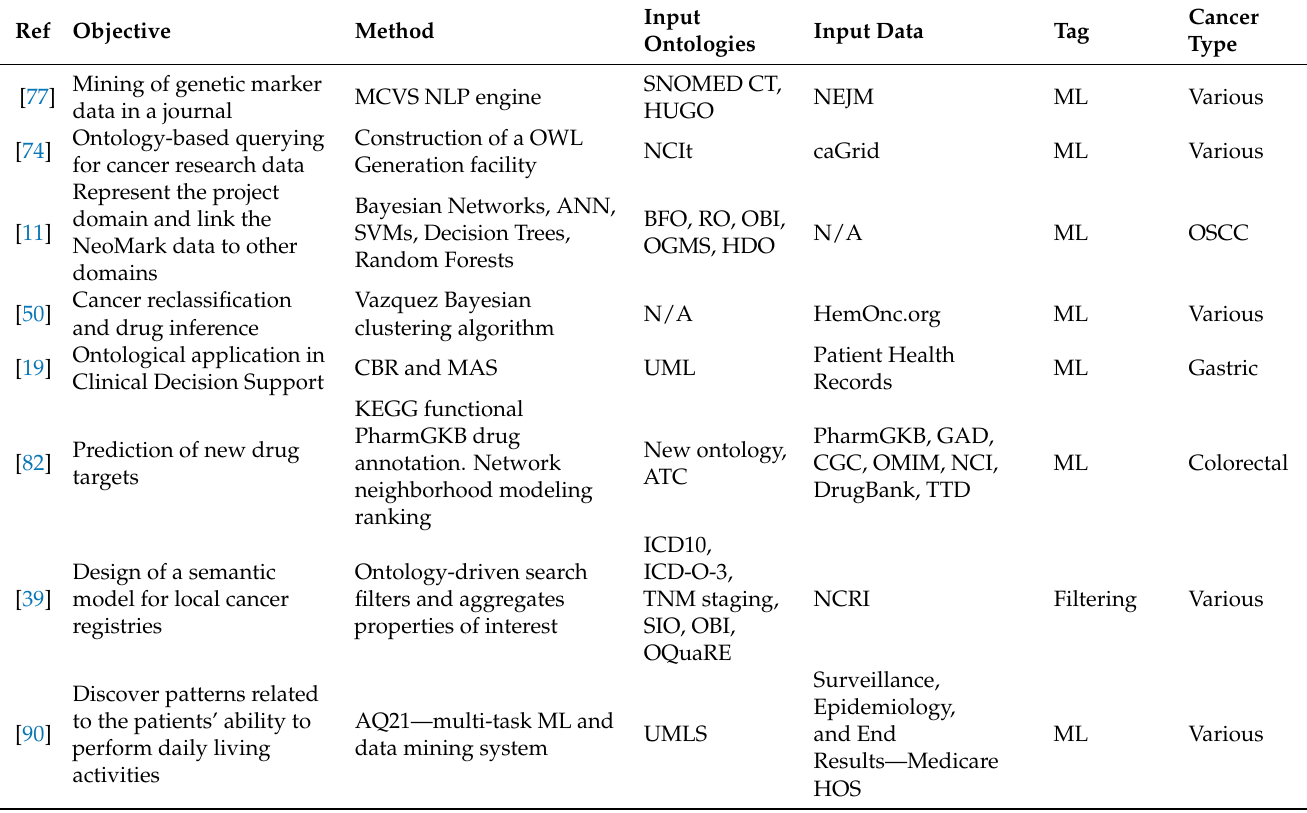
Table 4. Semantic-focused applications: mining and analyzing multimodal data with